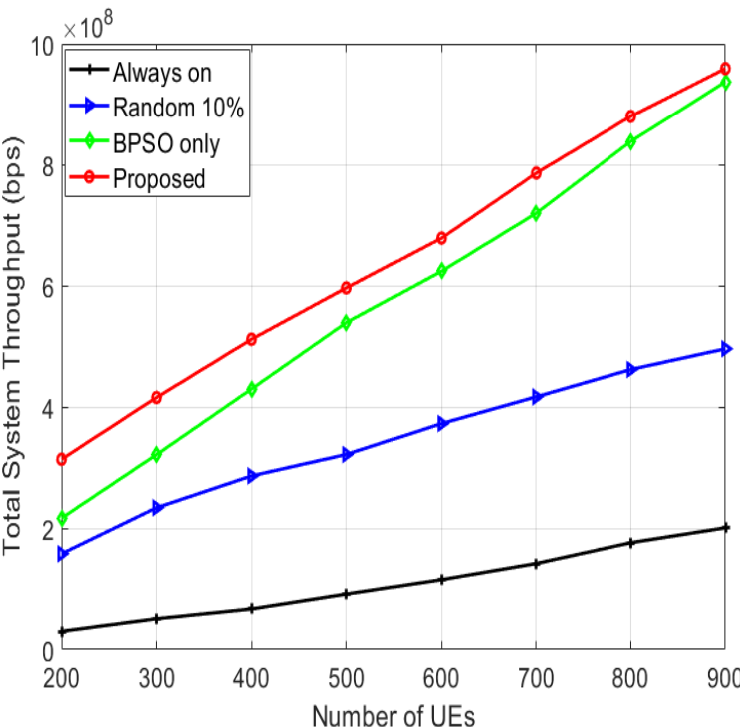
Figure 7. Total system throughput for various numbers of UEs.